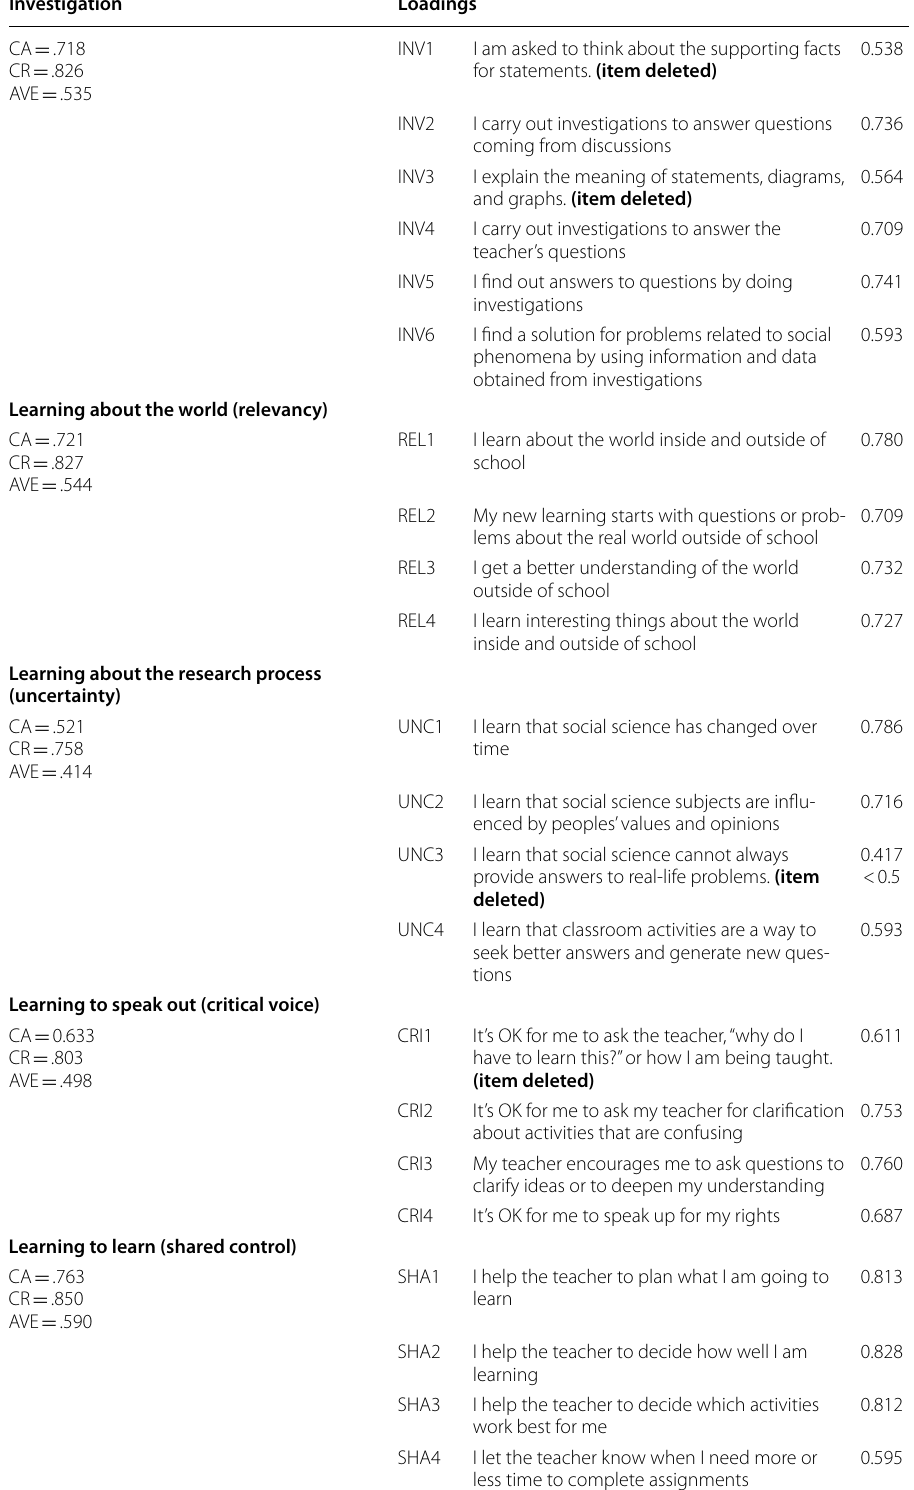
Table 3 SCLEQ list of terms, CA, CR, AVE, and Loadings adapted from (Aldridge et al., 2000; Luckay & Laugksch, 2015; Sultan et al.,